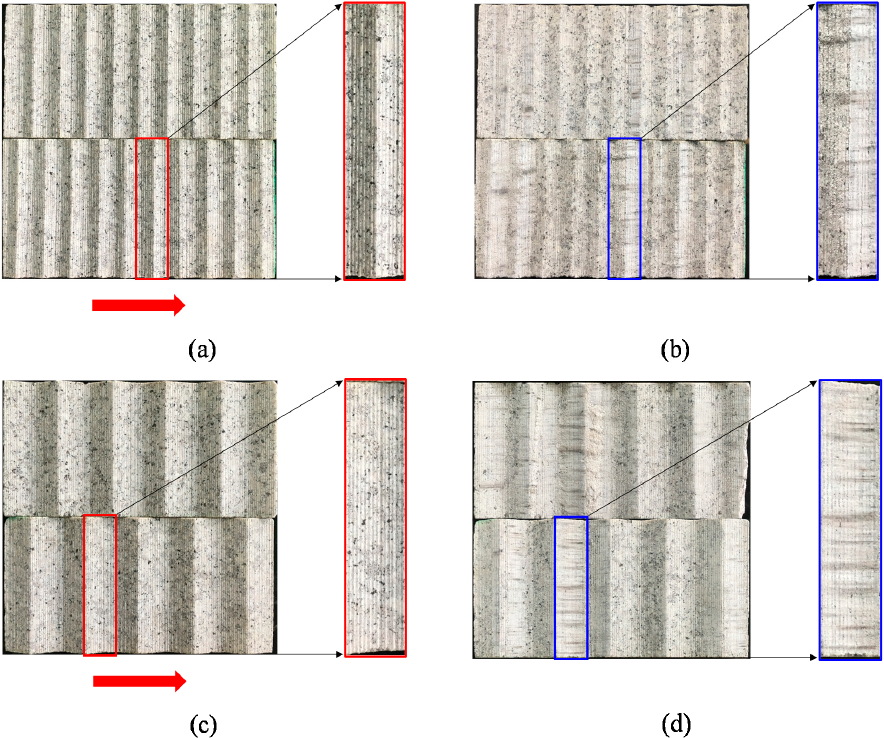
Figure 4. Morphology comparison for granite discontinuity samples 2# and 4# before and after tested ( a ) The top view of sample 2# before tested; ( b ) The top view of sample 2# after tested; ( c ) The top view of sample 4# before tested; ( d ) The top view of sample 4# after tested.